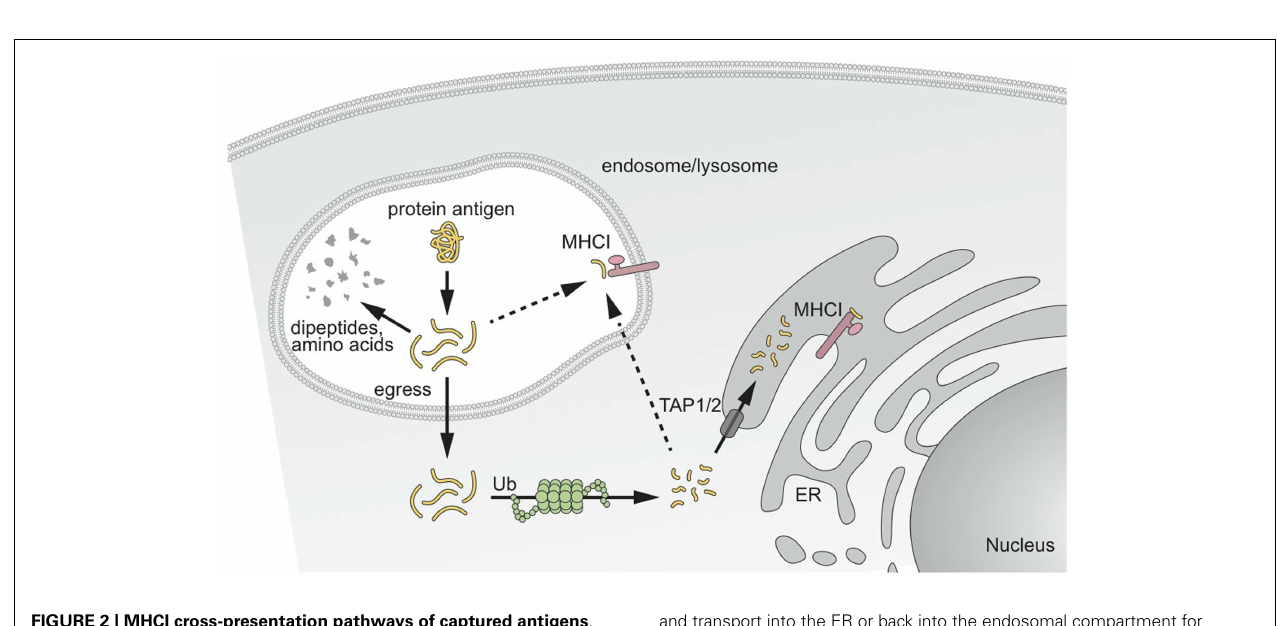
FIGURE 2 | MHCI cross-presentation pathways of captured antigens . Antigen captured by DCs has different potential fates. Antigens destined for cross-presentation on MHCI have two different intracellular routes. Antigen can be transported from the endocytic vesicles to the cytosol to access the classical MHCI pathway involving proteasomal degradation